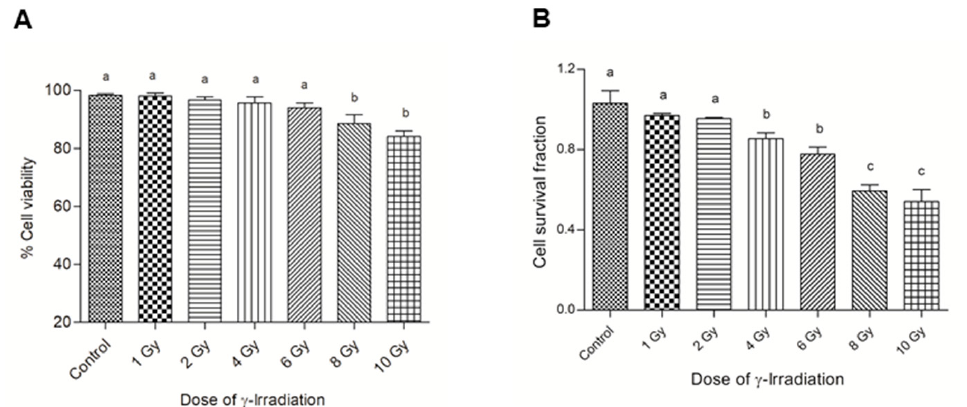
Figure 1. The viability ( A ) and survival fraction ( B ) of BEAS-2B cells after exposure to γ -irradiation. The cell viability was measured using the MTS assay. The survival fraction was determined using the clonogenic cell survival assay, where BEAS-2B cells were incubated for 24 h after irradiation. Then, the cells were re-seeded into 60 mm dishes and cultured for 21 days. Colonies were stained with crystal violet. Experimental values presented are mean ± SD of three independent experiments in triplicate. One-way analysis of variance was performed with Tukey’s pairwise comparison. Means that share the same letter are not significantly different at p ≤ 0.05.